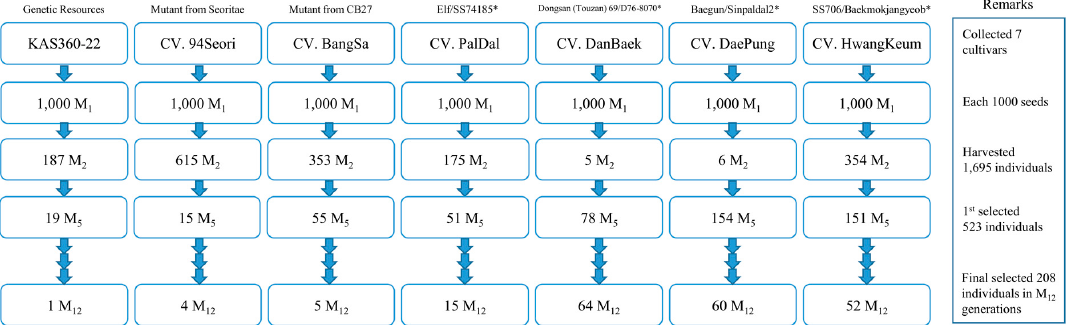
Figure 1. Schematic illustration of the breeding of M 1 –M 12 generations of 208 soybean mutant diversity pool (MDP) lines. * Information of cultivars was described in Lee et al. [27] pool (MDP) lines. * Information of cultivars was described in Lee et al.